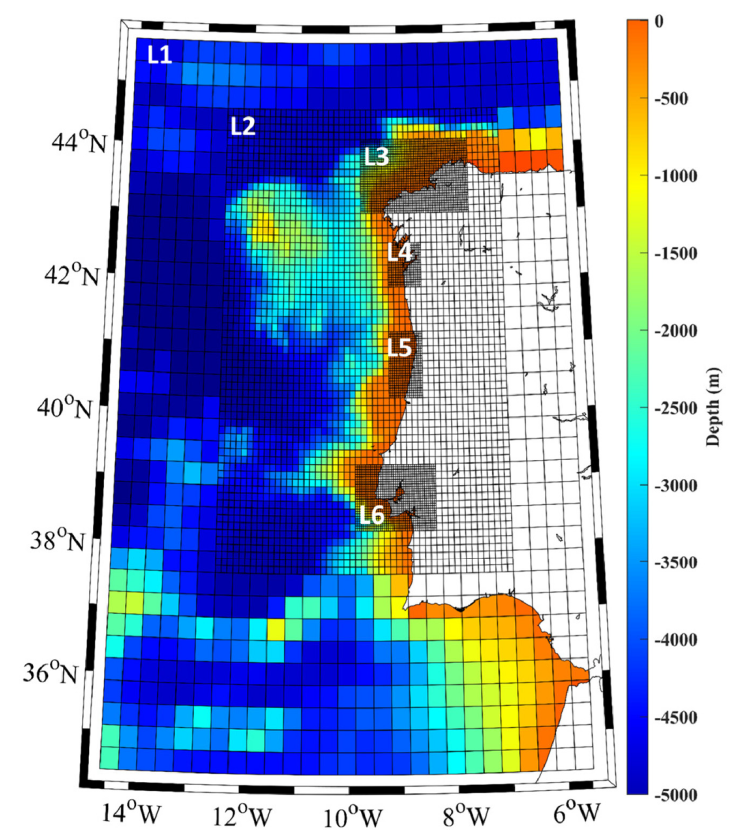
Figure 7. Numerical domains and bathymetry used for SWAN implementations, the downscale of the BCC-CSM1.1 GCM using a nested approach for the domains: L1 (1/3° × 1/3°), L2 (1/9° × 1/9°), L3, L4, L5 and L6 (1/27° × 1/27°).